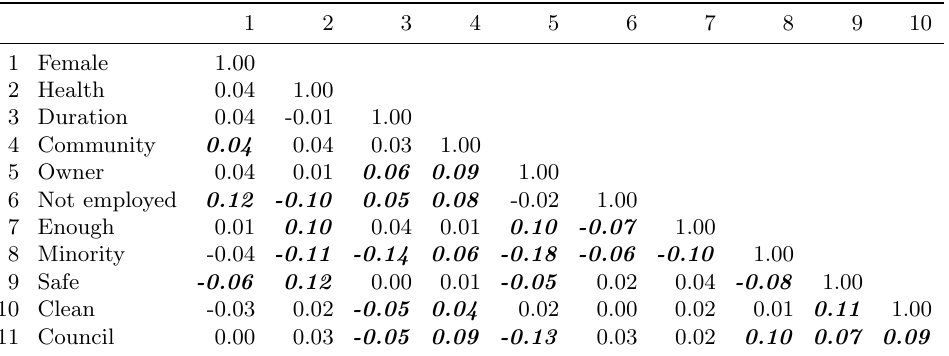
Table 4: Correlation matrix of urban pride arguments. New Zealand,